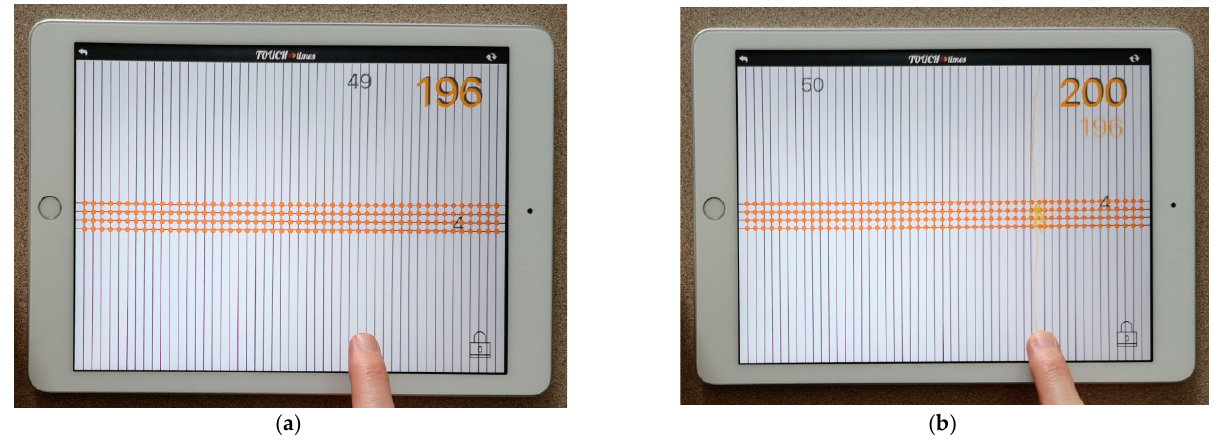
Figure 14. ( a ) Making the 49th; ( b ) the 50th four-ples in Zaplify.